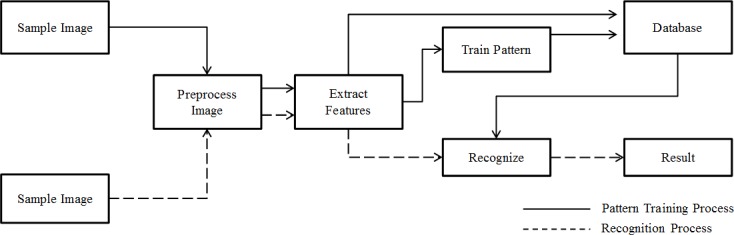
System architecture.